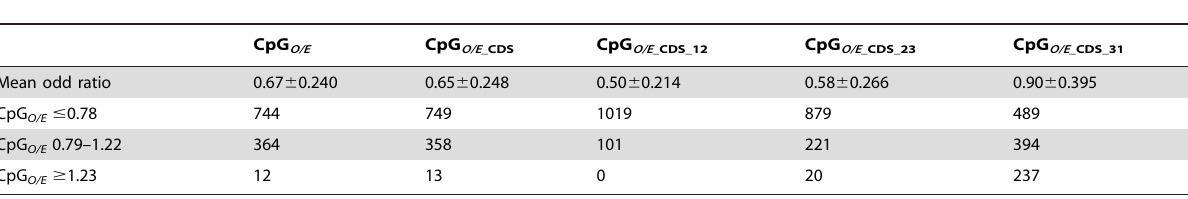
Table 1. CpG usage of RNA viruses.